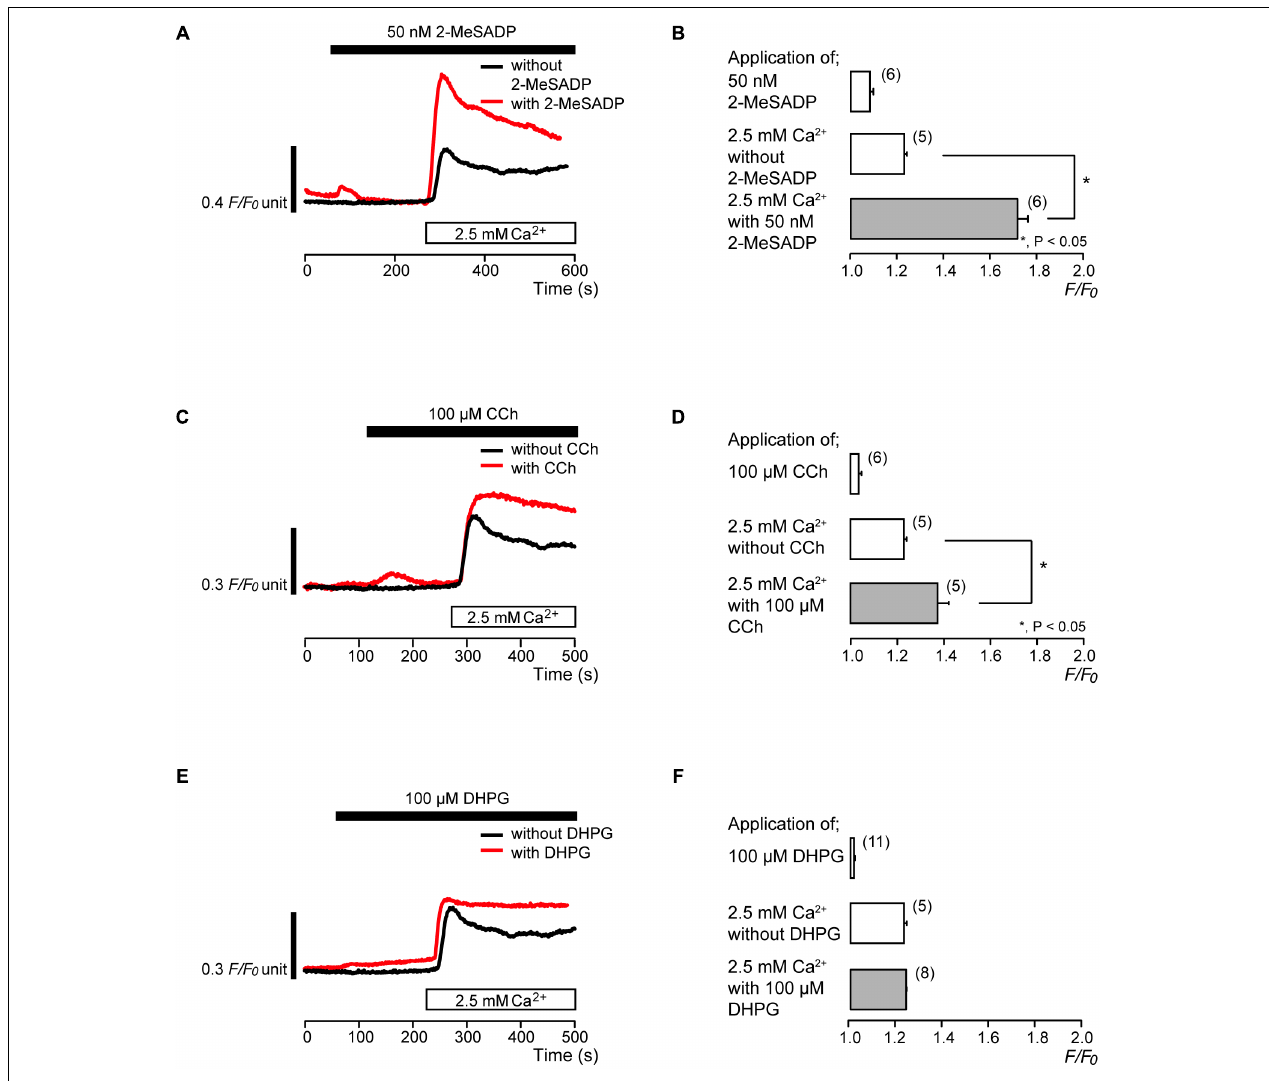
FIGURE 2 | Effects of PLC-coupled receptor agonists on the Ca 2 + influx. (A,C,E) Representative traces of [Ca 2 + ] i increase in response to application of PLC-coupled receptor agonists, 50 nM 2-MeSADP (A) , 100 µ M CCh (C) , or 100 µ M DHPG (E) , and subsequent application of 2.5 mM extracellular Ca 2 + (white box at bottom) with (red line), or without (black line) agonists (A,C,E) . Black boxes at the top indicate the application time period of 50 nM 2-MeSADP (A) , 100 µ M CCh (C) , or 100 µ M DHPG (E) . (B,D,F) Summary bar graphs show [Ca 2 + ] i increase by application of 50 nM 2-MeSADP (B) , 100 µ M CCh (D) , or 100 µ M DHPG (F) (upper column) and subsequent application of 2.5 mM extracellular Ca 2 + in the presence (gray column) or absence (middle column) of these agonists. Each column indicates the mean ± SE of 5–11 independent experiments. Statistically significant differences between columns (shown by solid lines) are denoted by asterisks, ∗ P <